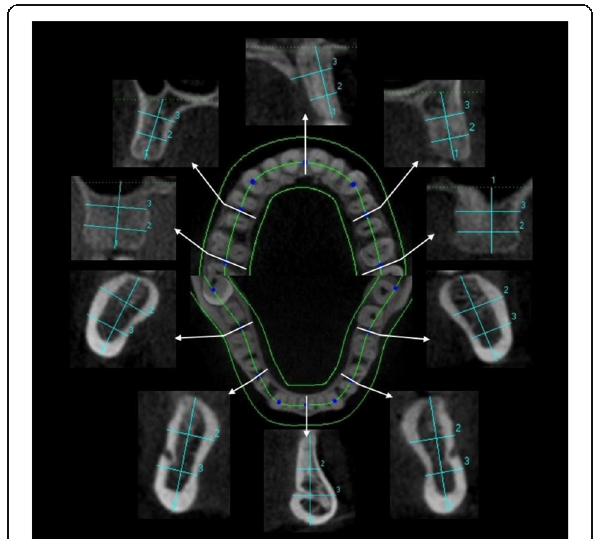
Fig. 2 Cross-sectional bone measurements of the maxilla and mandible. One height and two width measurements at each site were measured. The sites were named according to location to the neighbouring teeth. I.e UP-MOL R upper molar right (side).